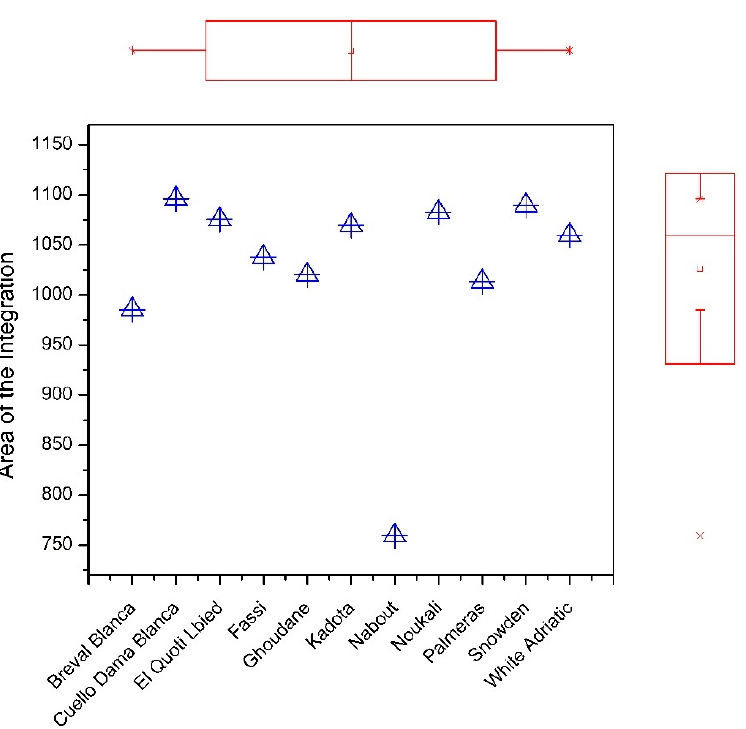
Figure 3. Marginal boxplot chart showing the total integrated area of the entire IR spectrum for each